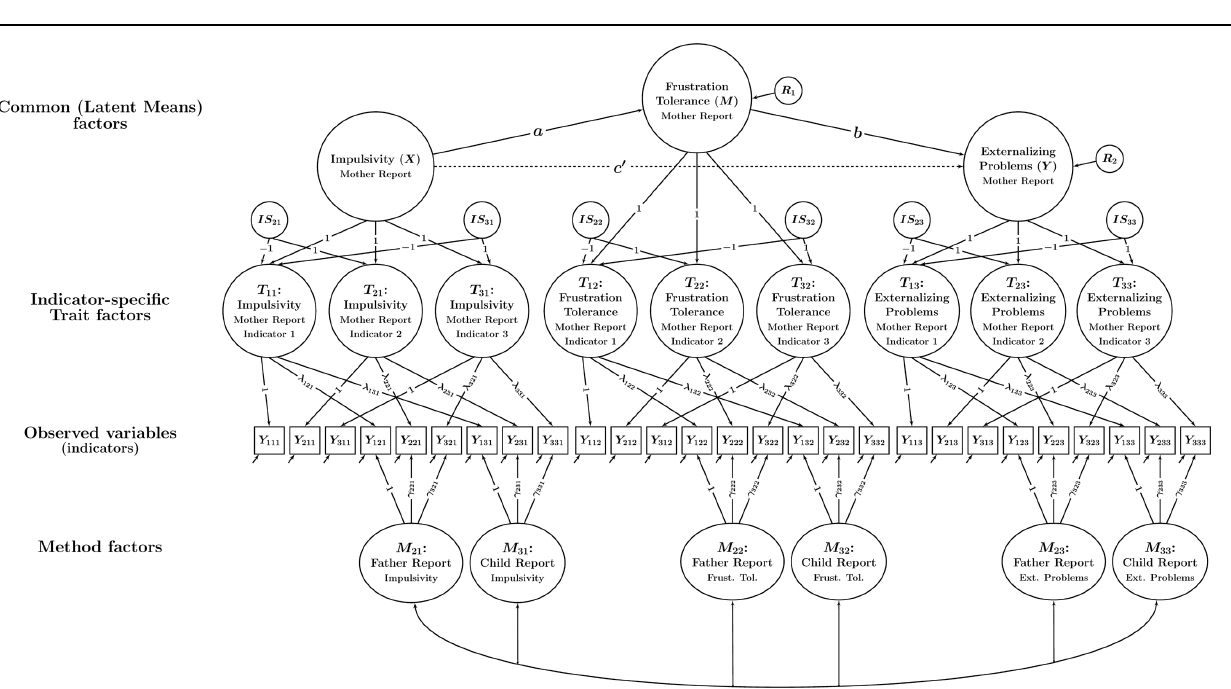
FIGURE 5 | Path diagram illustrating a CT-C( M – 1) mediation model with a single trait factor per trait. In this model, statistical mediation is examined between latent trait factors. The parameters a , b , and c ’ denote path (regression) coefficients. R 1 and R 2 : latent residual variables. All other parameters are the same as in Figure 3 .